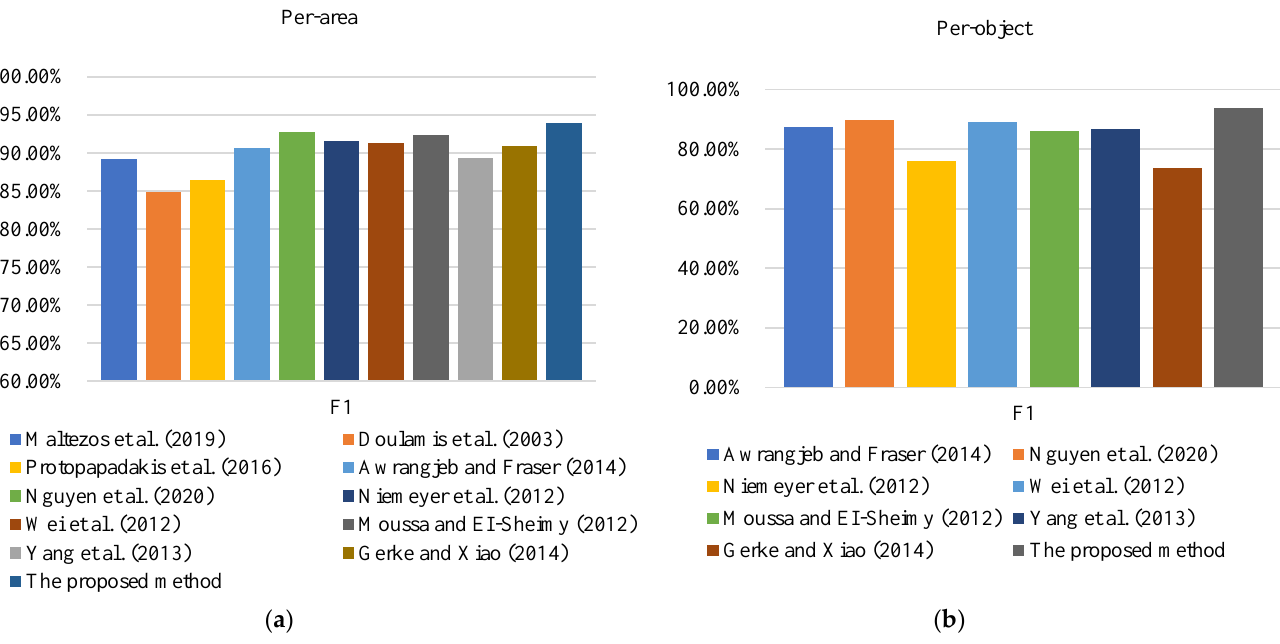
Figure 7. Average F1 score comparison between the proposed method and ten other methods. ( a ) Per-area level; ( b ) per- object level. The F1 score of the ten methods are obtained from the corresponding references. The methods proposed by Maltezos et al. (2019), Doulamis et al. (2003) and Protopapadakis et al. (2016) do not provide the quality at per-object level.